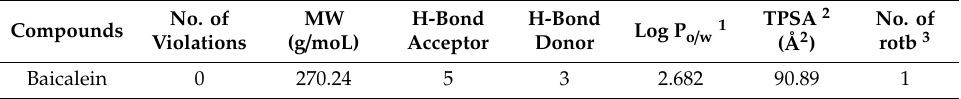
Table 4. In Silico drug-likeness property through Lipinski’s